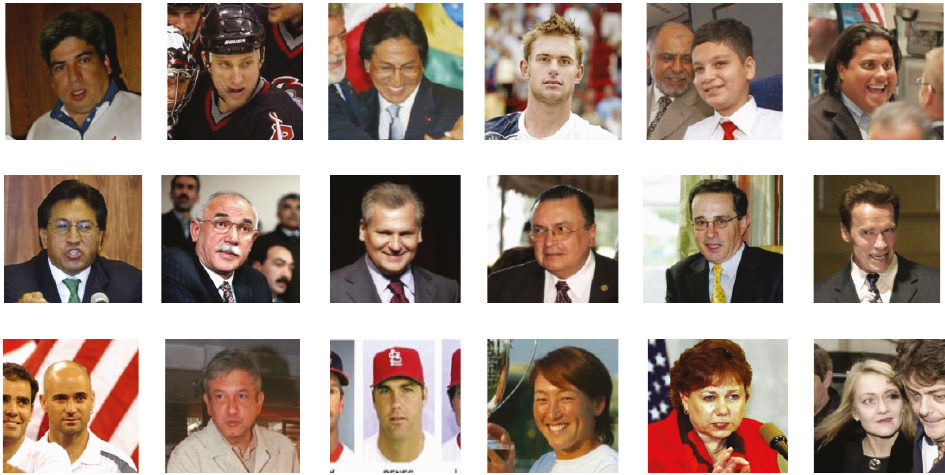
Figure 3: Examples of faces from the LFW, randomly selected from people with name starting with A.